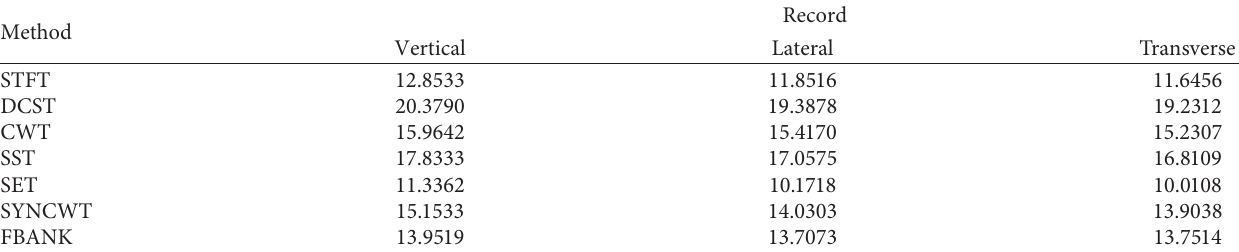
Table 1: Renyi values of Mosha3 station accelerogram components.